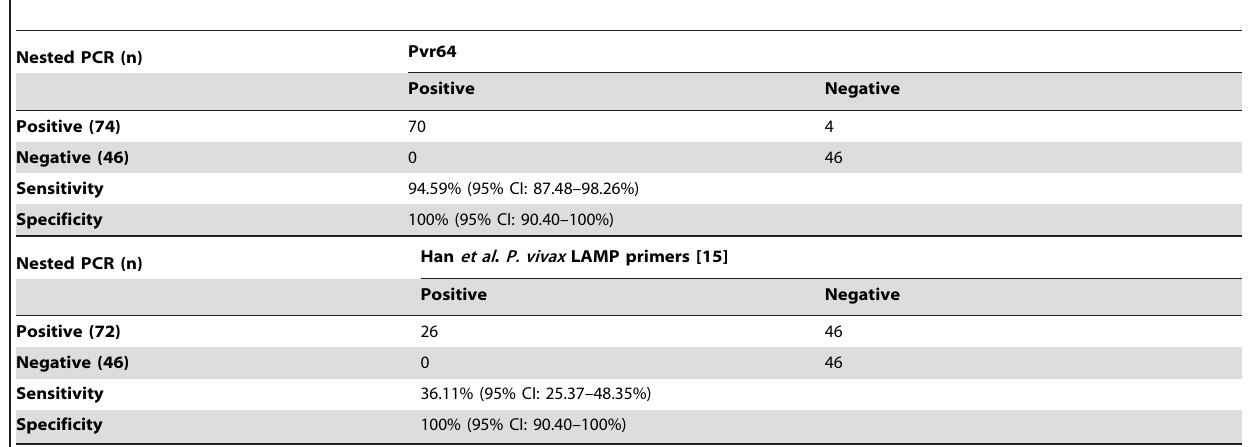
Table 3. Sensitivity and specificity among clinical sample of r64 primer set and published P. vivax LAMP primers.